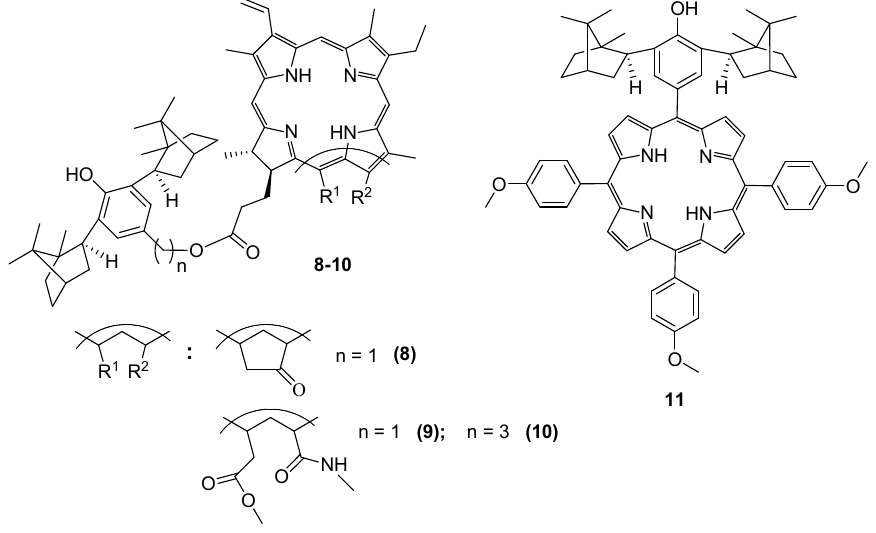
Figure 2. Structure of the conjugates 8 – 11 .